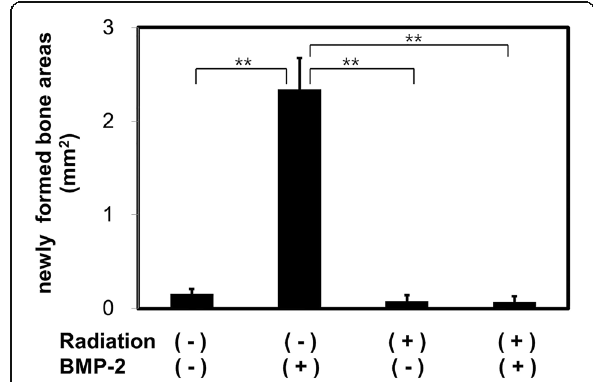
Fig. 6 Analysis of new bone formation area from histological specimens. **Significant inter-group difference to the other group ( p <